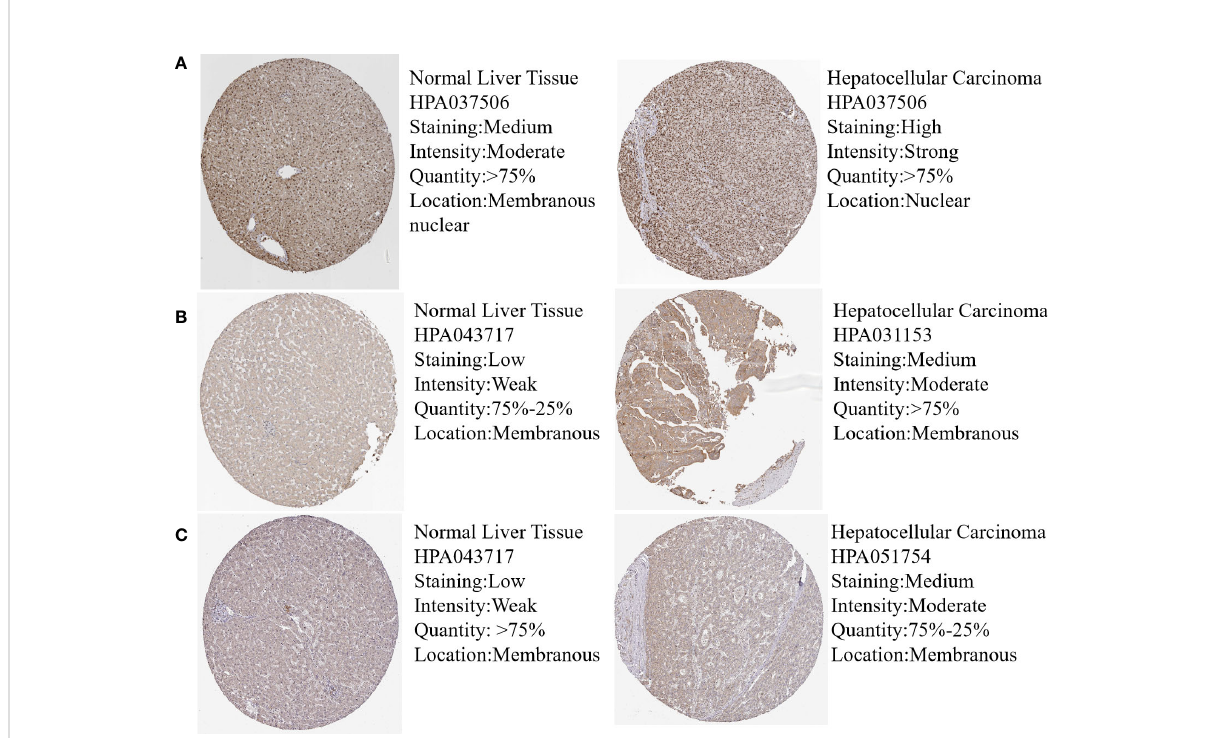
FIGURE 8 Protein expression of hub genes in normal and HCC liver tissues. Protein levels of POLR2B (A) , RPS6 (B) and RPL23A (C) in normal liver tissue and HCC liver